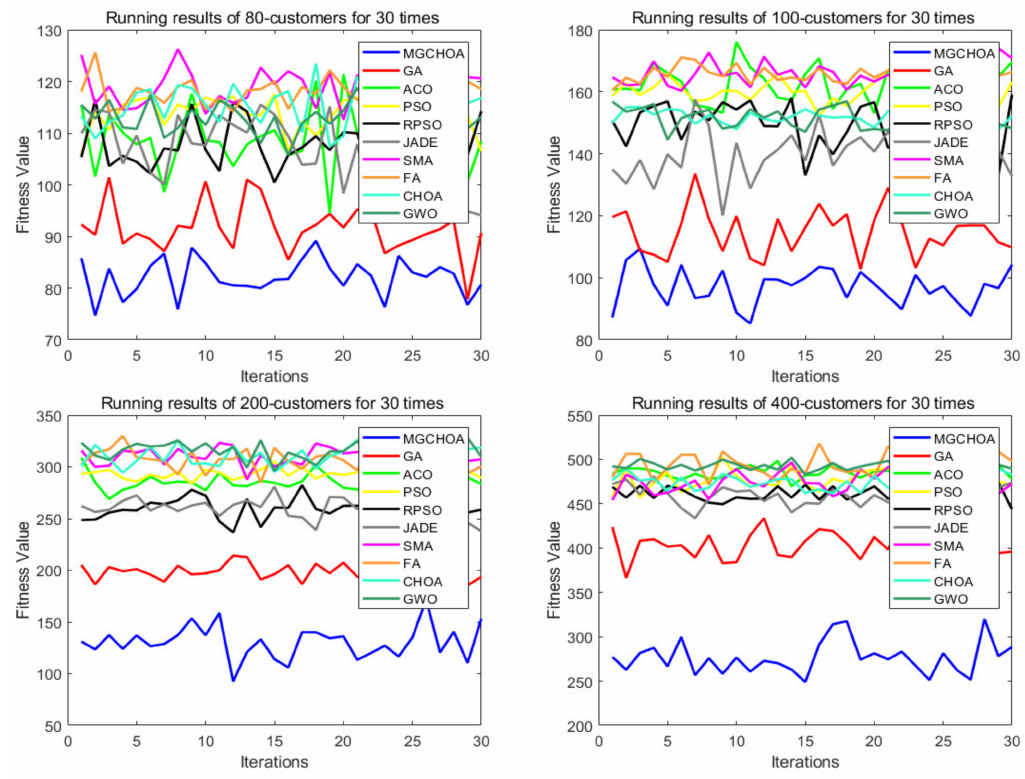
Figure 12. The results of 30 runs by